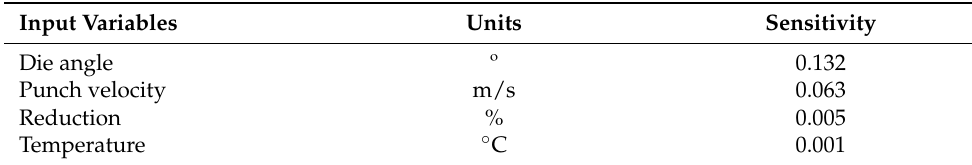
Table 2. Sensitivity analysis results for the input variables.